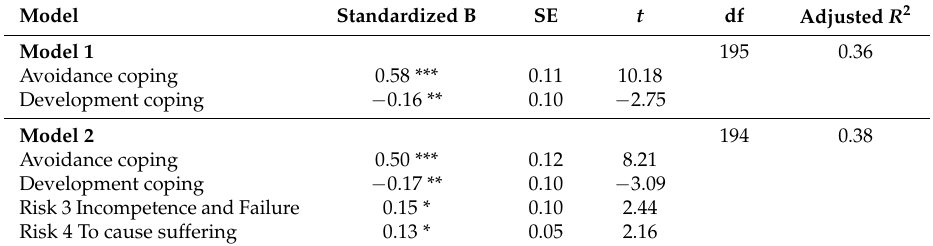
Table 2. Results of the two sets of stepwise regression analyses on suicidal